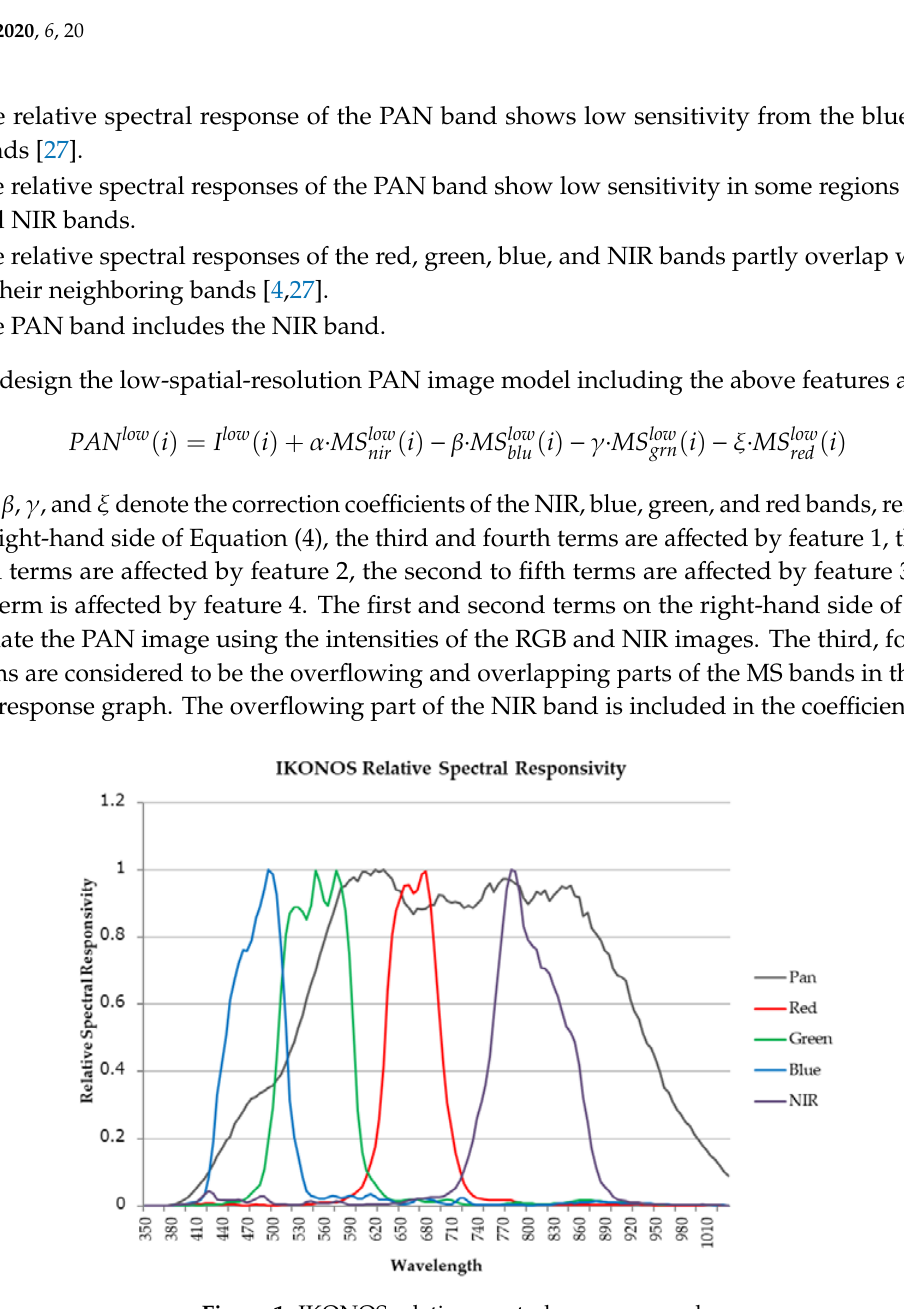
Figure 1. IKONOS relative spectral response graph.